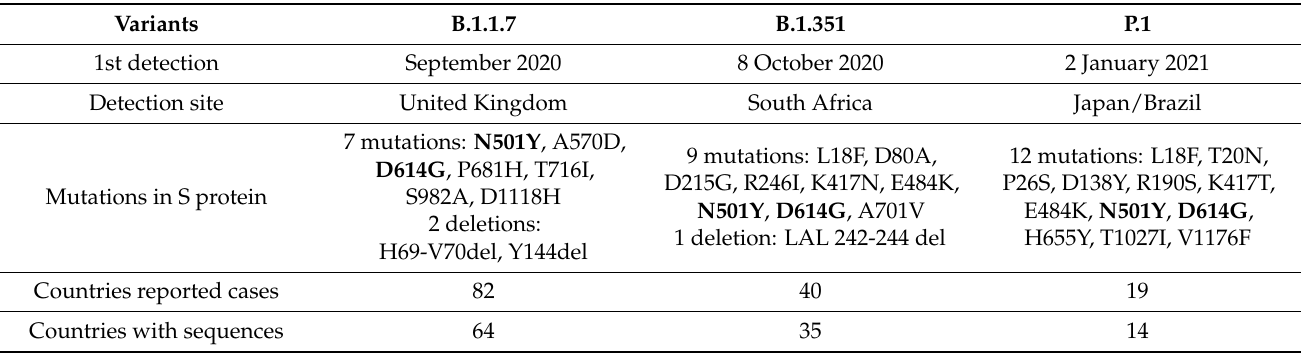
Table 1. Main characteristics of the emergent severe acute respiratory syndrome coronavirus-2 (SARS-CoV-2) variants. Data updated on February 16 2021 (https://outbreak.info (accessed on 9 March